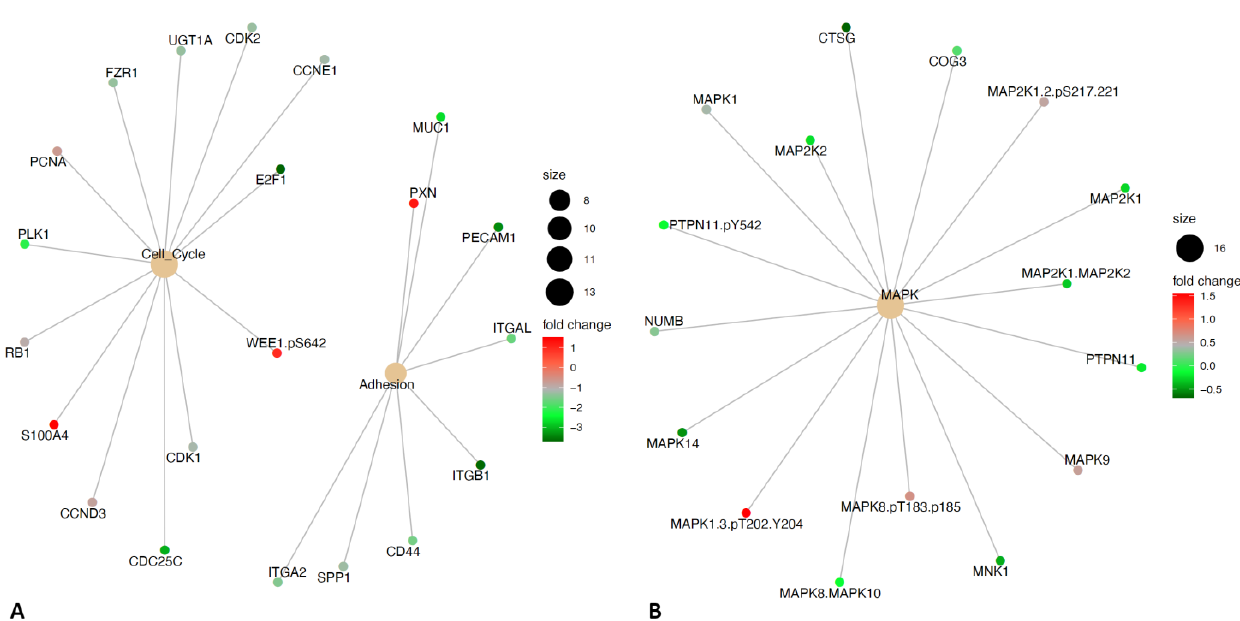
Figure 6. Network plots of Enriched Differentially Expressed Protein Functions when comparing all patient DDR clusters to CD19 controls ( A ) and when comparing the good prognostic cluster C3 to the poor clusters ( B ). Large nodes denote the functional groups and small nodes denote the proteins differentially expressed within each function. In figure ( A ), the color of the protein nodes depicts the average log fold change in expression across all clusters compared to the controls. In figure ( B ), the color scale represents the fold change of cluster C3 patients’ differentially MAPK signaling proteins when compared to C2.